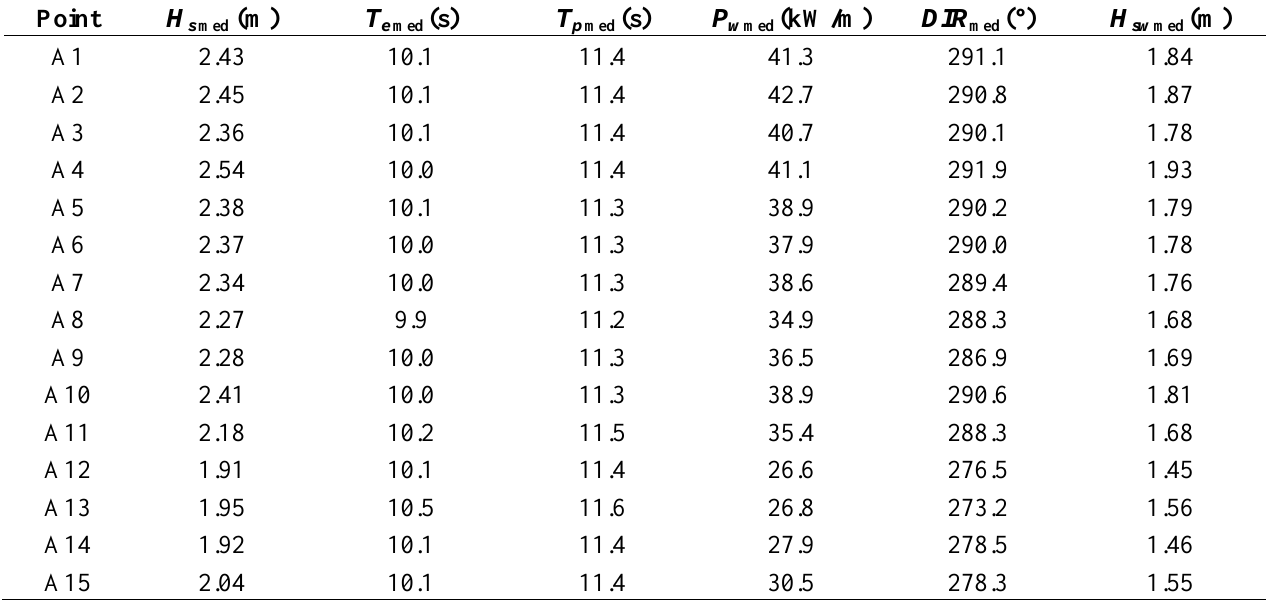
Table 3. Average values for the main wave parameters in the reference points from the northern computational domain (A-points) as resulting from the simulations performed in the three-year period 2009–2011 (only for winter time).